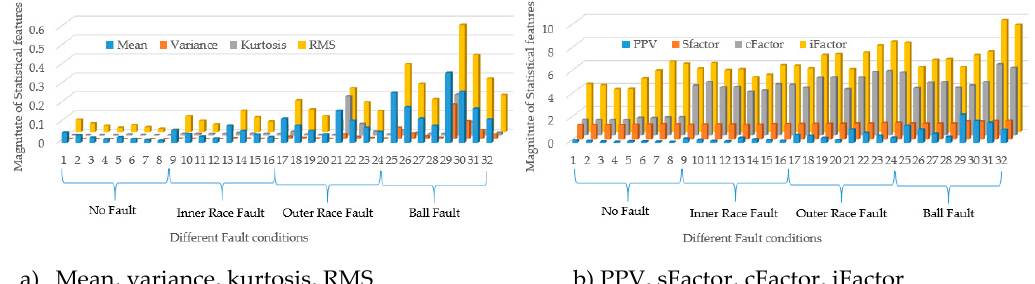
Figure 6. The four ‐ level wavelet decomposition of four classes of bearing conditions.